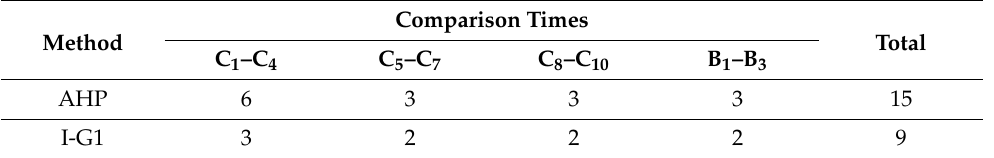
Table 5. Calculation volumes of AHP method and improved G1 method.